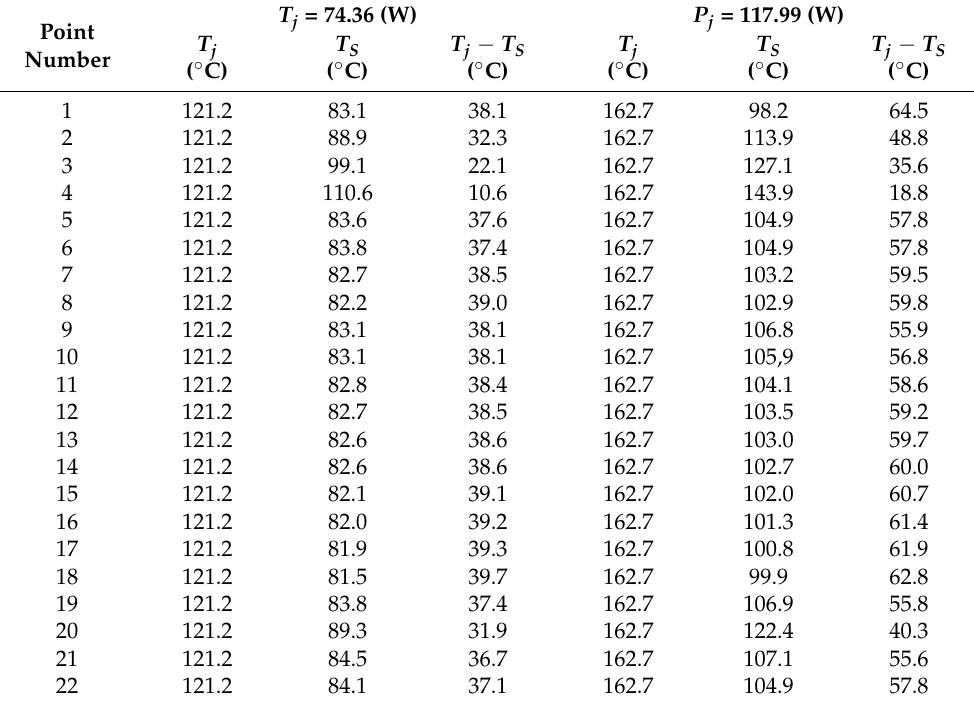
Table 7. The differences between the junction temperature ( T j ) and the temperatures at the points shown in Figure 2 ( T S ) for P j = 74.36 W and P j = 117.99